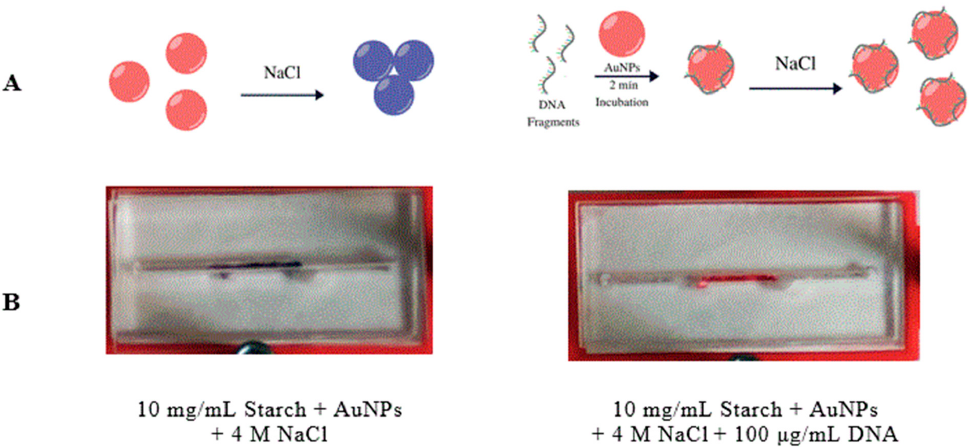
Figure 5. A scheme of the reactions that take place in the biosensor. ( A ) AuNPs exposed to an oversaturated salt solution (NaCl) in the absence of DNA (left) can aggregate and its color changes to blue. AuNPs incubated with DNA prior to salt addition (right), do not aggregate and the red color remains. ( B ) Images of the biosensor were taken showing colorimetric responses.